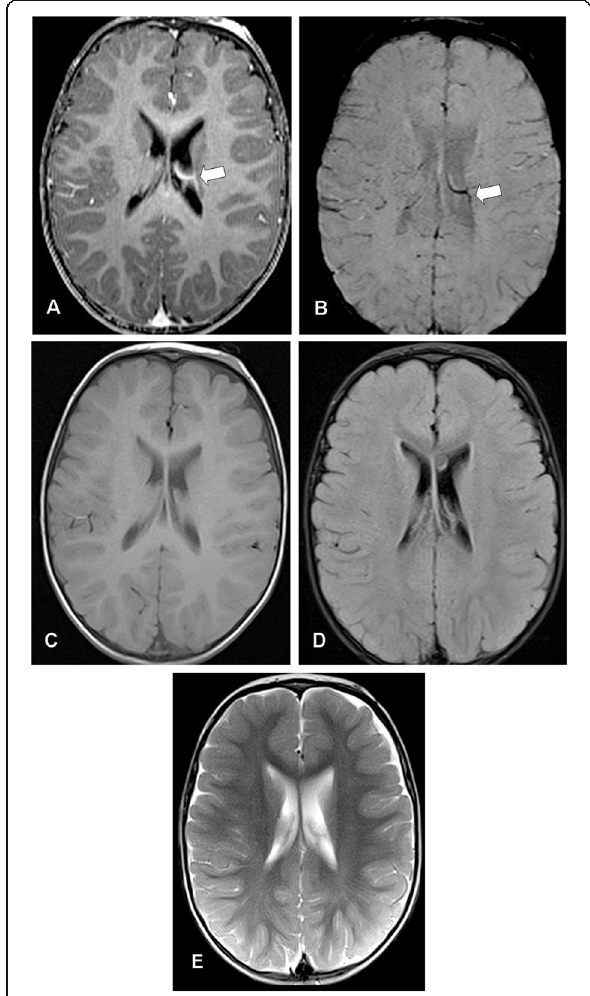
Fig. 5 Contrast-enhanced T1W ( a ) and SWI ( b ) show a small DVA in the left frontal lobe (arrow). The lesion is less clearly demonstrated on non-contrast T1W ( c ), FLAIR ( d ), and T2W ( e ) with no definite